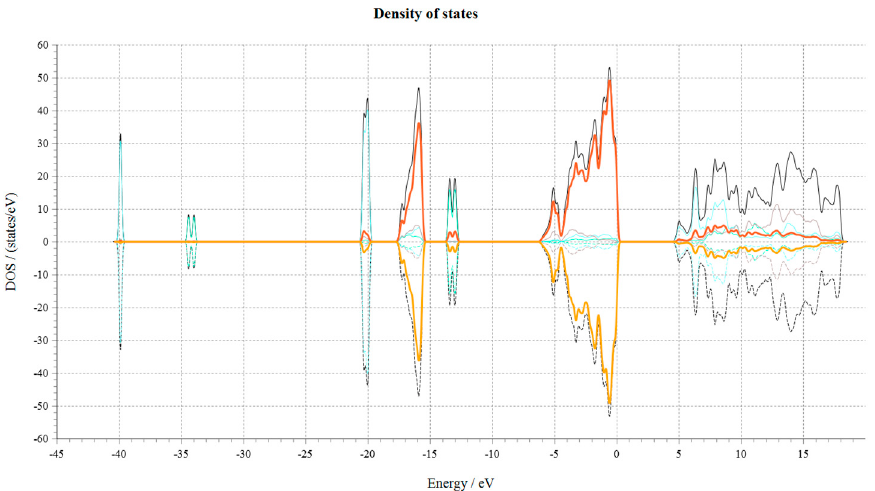
Figure 17. The density of states of YAG:Eu (four ions).